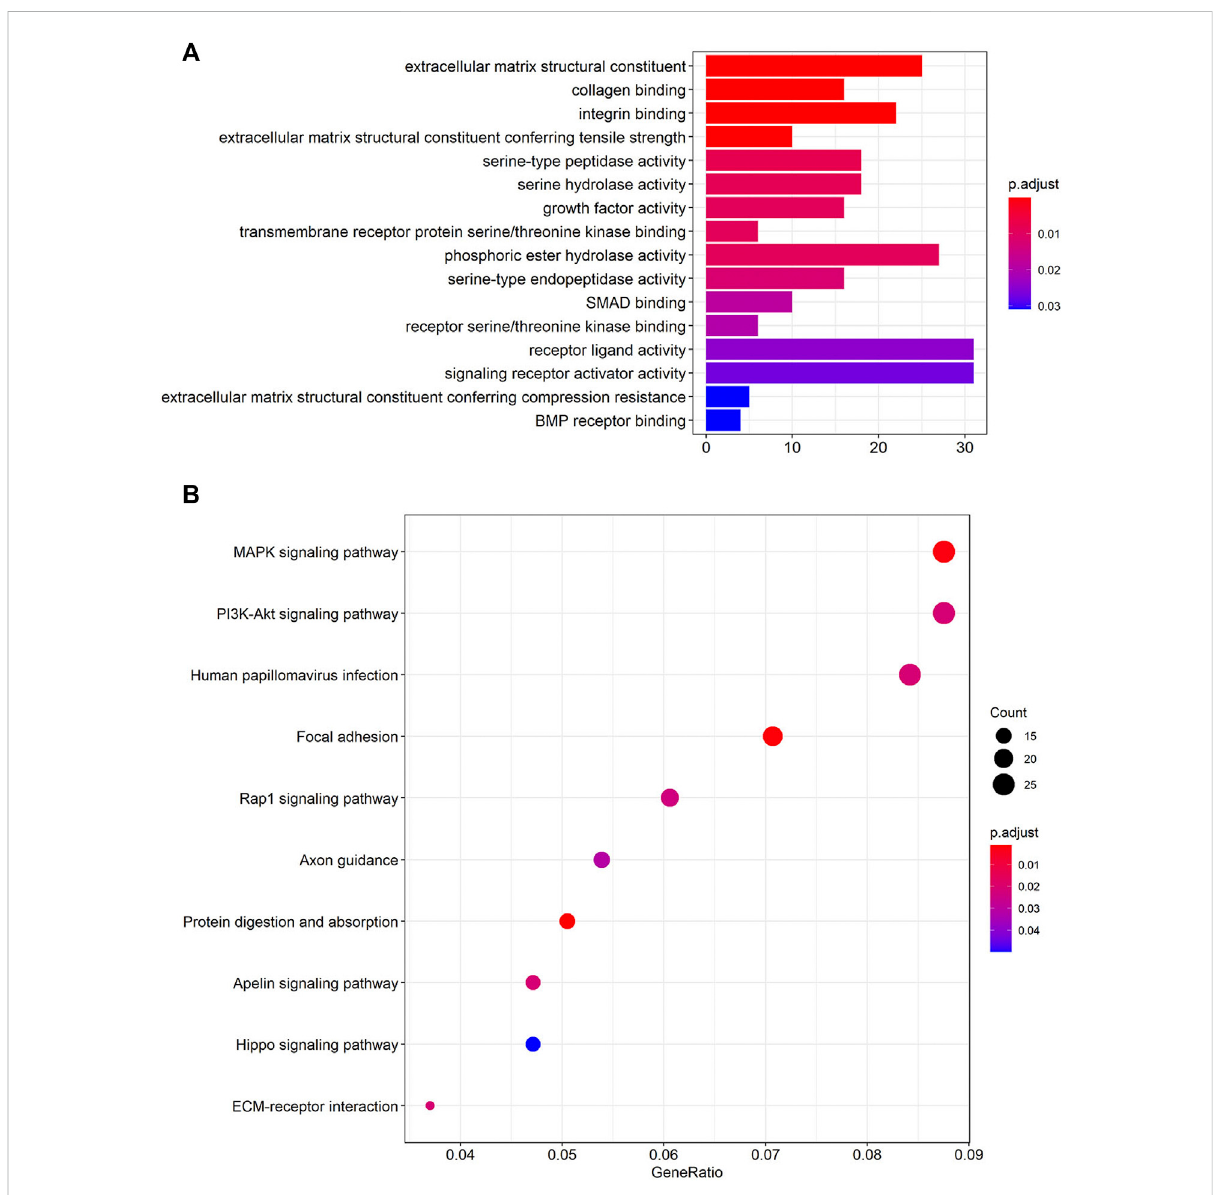
FIGURE 4 Functional enrichment analysis of the four lncRNAs based on their correlated protein-coding genes (PCGs). (A) GO enrichment analysis of PCGs. (B) KEGG pathway enrichment analysis of PCGs. GO: Gene Ontology; KEGG: Kyoto Encyclopedia of Genes and Genomes (Lorent et al., 2014; Liu et al., 2020; Kanehisa et al.,